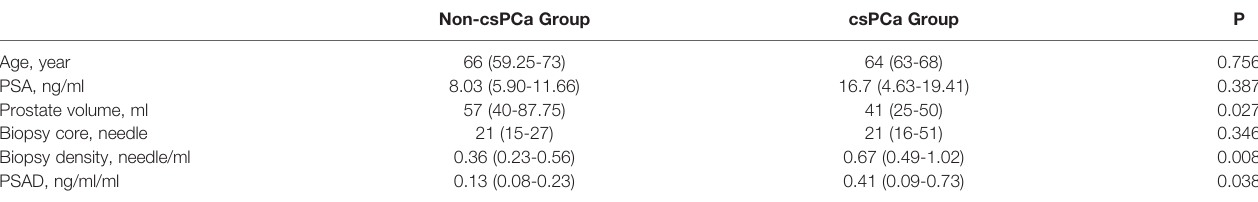
TABLE 2 | Comparison of baseline information of patients with csPCa and non-csPCa